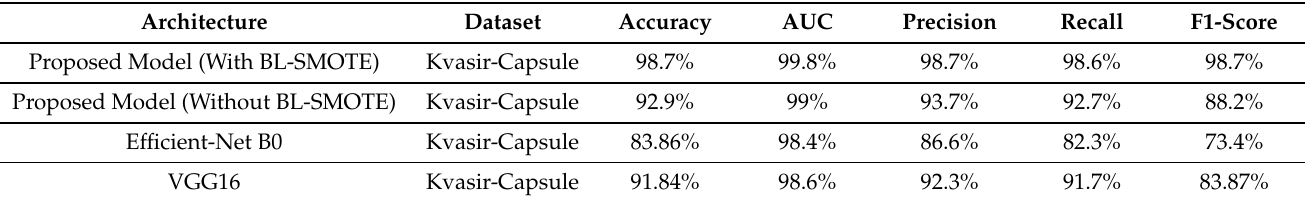
Table 5. We selected the same parameters for all the networks to fairly examine their performance. Table 5. Performance comparison of proposed CNN model and other state-of-the-art algorithms.